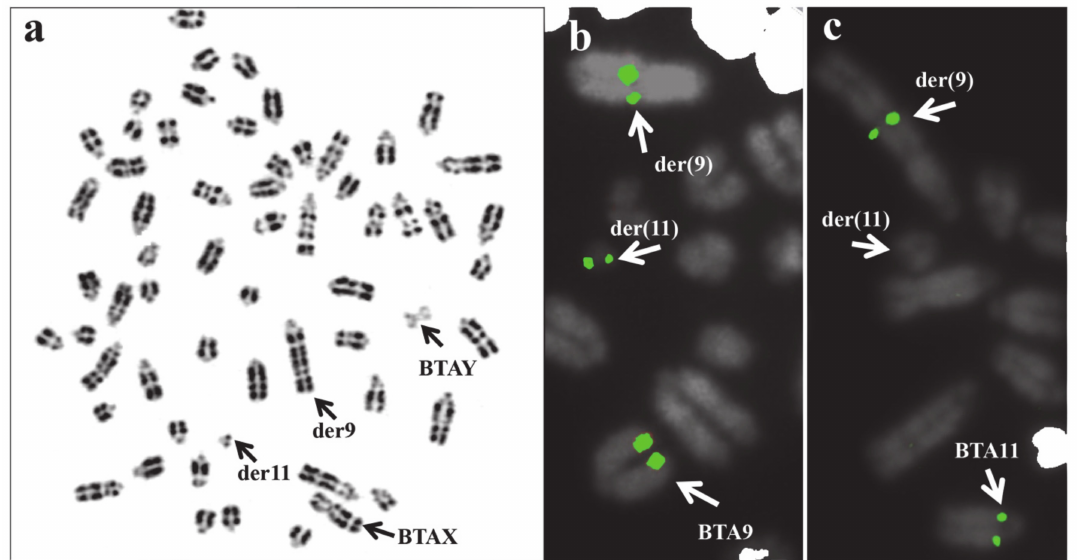
Figure 6. ( a ) Cattle metaphase treated for RBG banding and showing a case of rcp(9;11) (q27;q11) in a young male for reproduction. Arrows indicate the sex chromosomes der(9) and der(11). FISH mapping with two chromosome-specific BAC clones mapping on BTA9 and BTA11 confirmed the chromosomes involved in the rcp ( b , c ). Note the presence of FITC signals of a BTA9 marker in BTA9, der(9), and der(11) ( b ), as well as of FITC signals of a BTA11 marker only in BTA11 and der(9), being absent in der(11) ( c ) because the chromosome region was positioned after the break